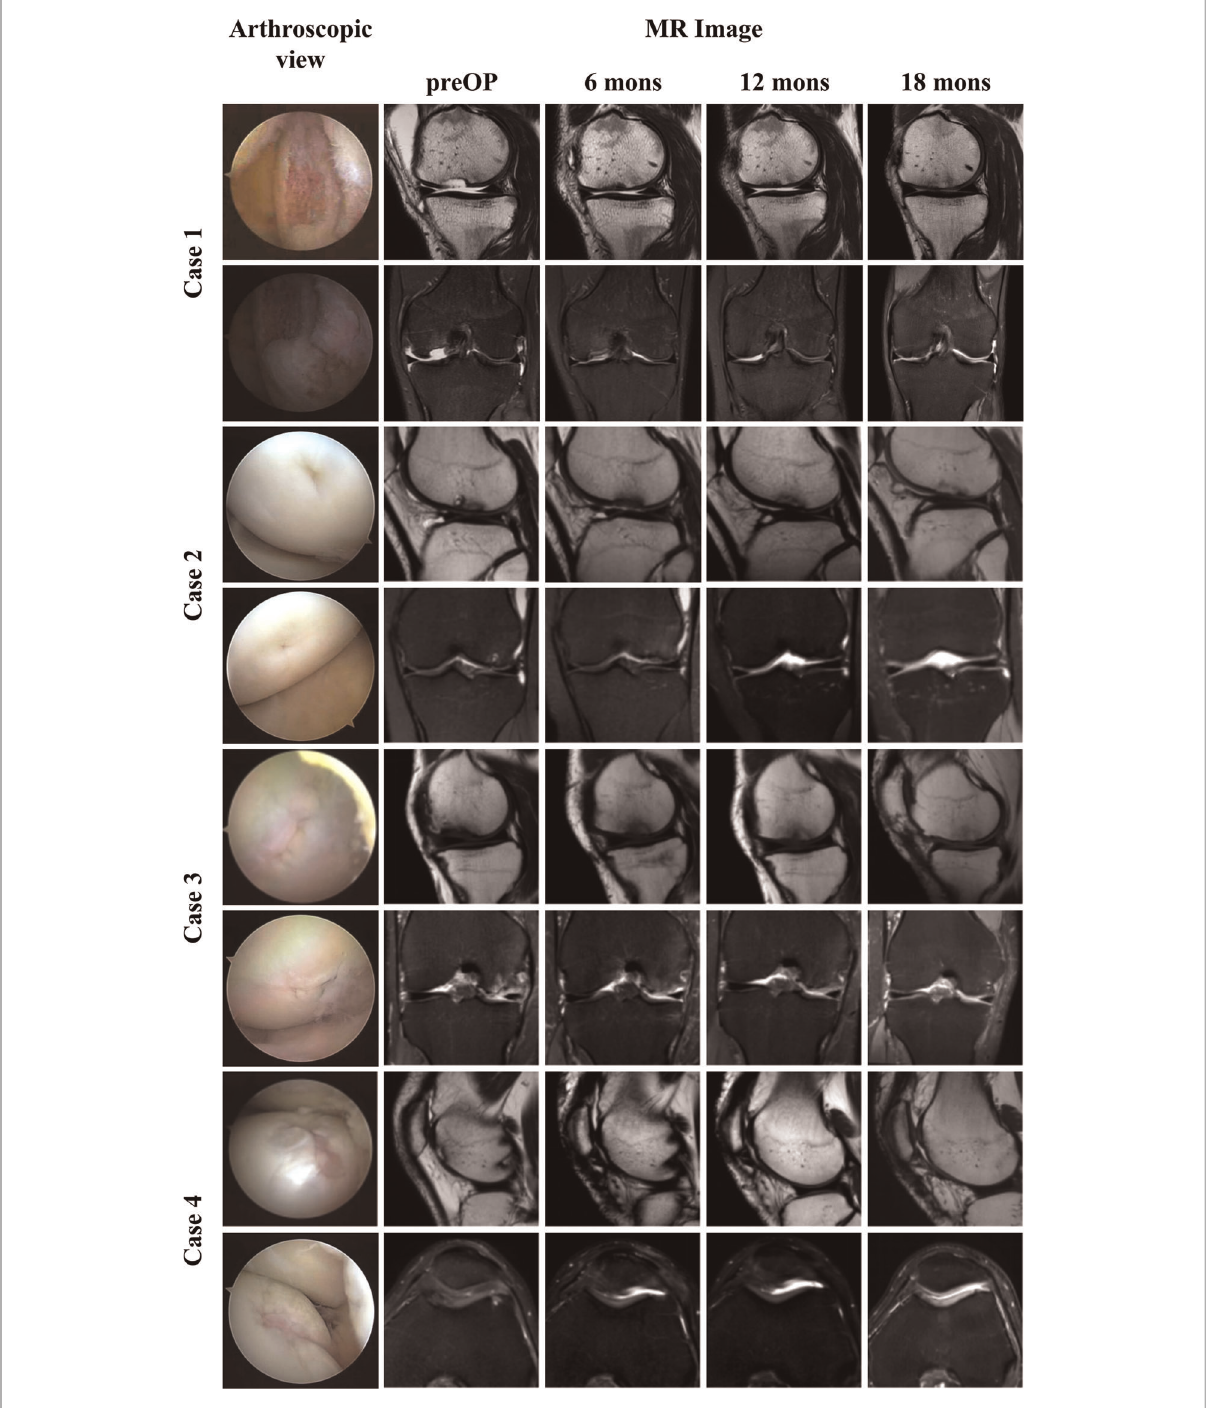
FIGURE 4 Arthroscopic view and MR images of four patients. The fi rst column: arthroscopic view of cartilage defect. The second to fi fth columns: Sagittal T2- weighted, coronal, or axial PD-weighted MR images of four patients from pre to 18 months after